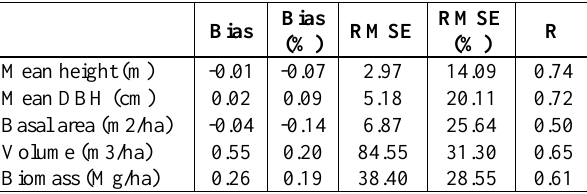
Table 6. Summary of results using TSX stereo 3D